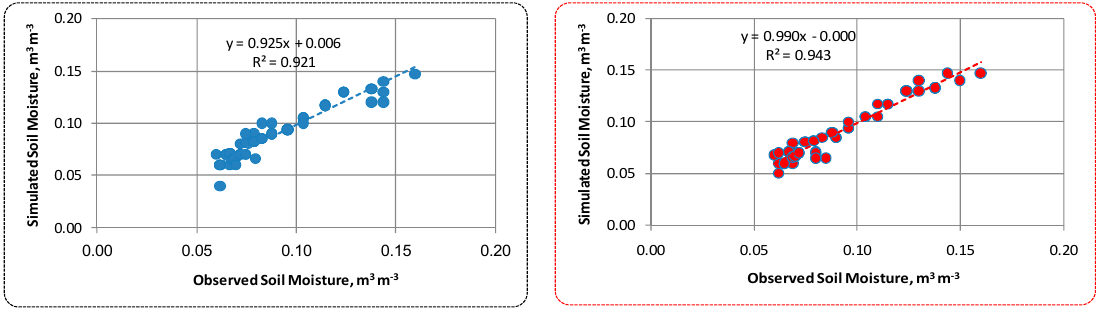
Figure 5. Observed and simulated soil moisture at a depth of 0–30 cm, during the 2017/2018 season, for overall validation treatments: drainage water from fish farms (DWFF), fresh irrigation water (IW) and Nitrogen (N).